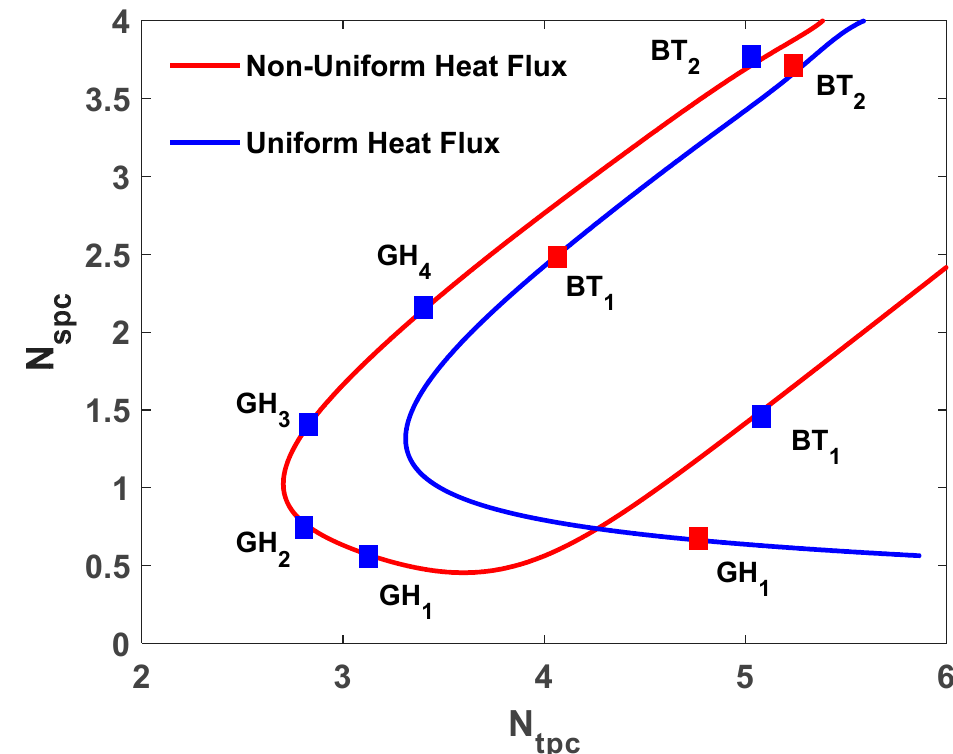
Figure 8. Stability characteristics of three parallel channels using a Six-node approach.